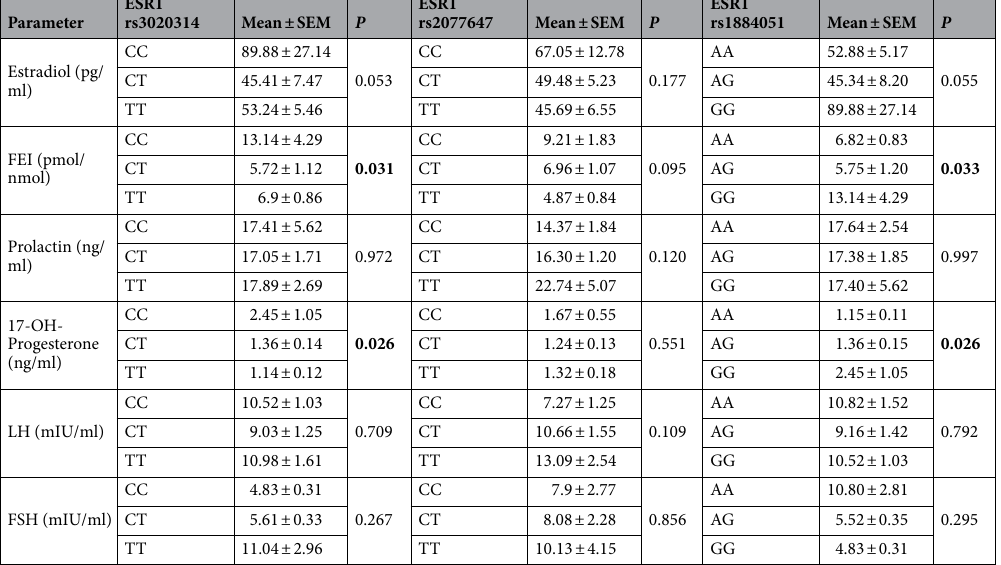
Table 2. Analysis of female hormonal parameters in relation to ESR1 gene polymorphisms in patients with hyperandrogenism. FEI Free Estradiol Index, LH luteinizing hormone, FSH follicle stimulating hormone. Significant values are given in